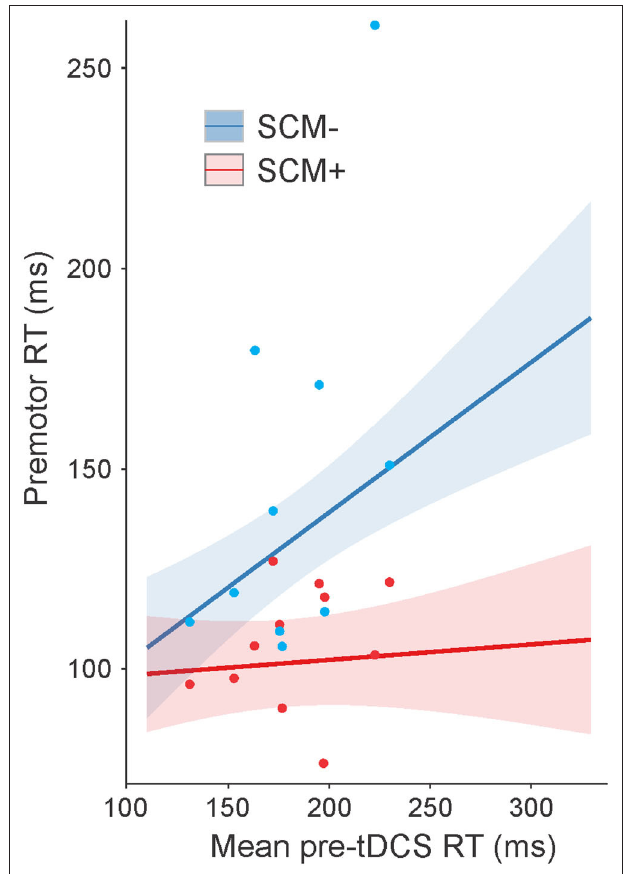
FIGURE 3 | Model-fitted predicted premotor reaction time (RT) on startle (SAS) trials collapsed across tasks as a function of mean pre-tDCS control trial RT. The red line shows predicted RT for trials where a startle reflex in sternocleidomastoid (SCM) was observed (SCM + ), and the blue line shows predicted RT for trials where a startle reflex was not observed (SCM–). Shaded areas represent 95% CI. Dots represent participant mean RT values (note that these means are collapsed across tasks with different pre-tDCS mean RT values, and the model takes all individual data points into consideration).